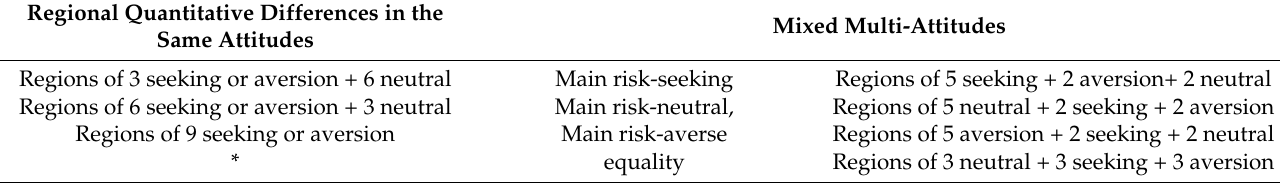
Table 1. Model design